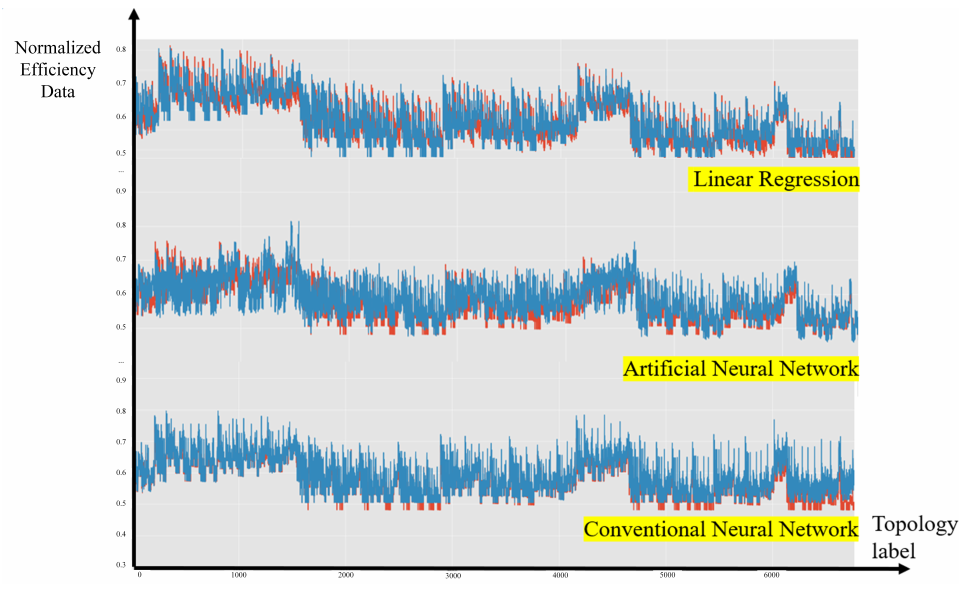
Figure 10. Comparison with other machine learning